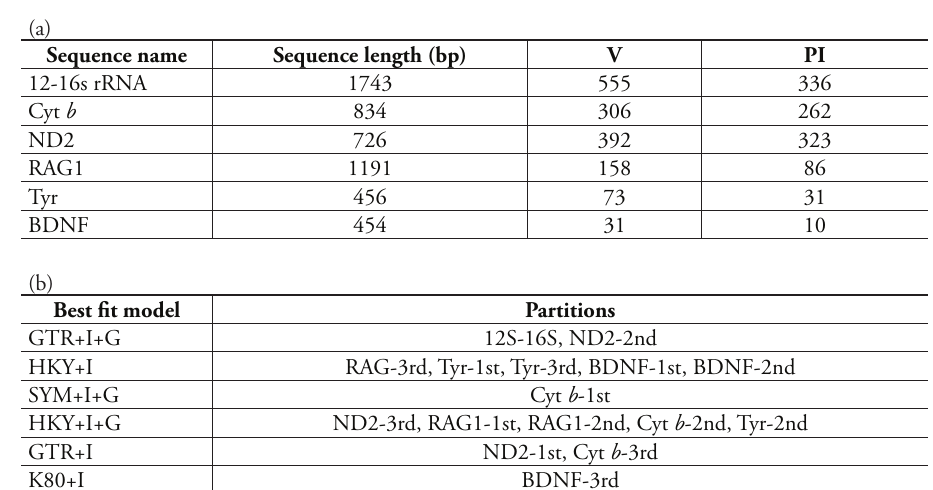
Table 3. Sequence information (a) and results of model selection by PartitionFinder (b). “V” and “PI” indicated the variable sites and parsimony-informative sites of each locus,